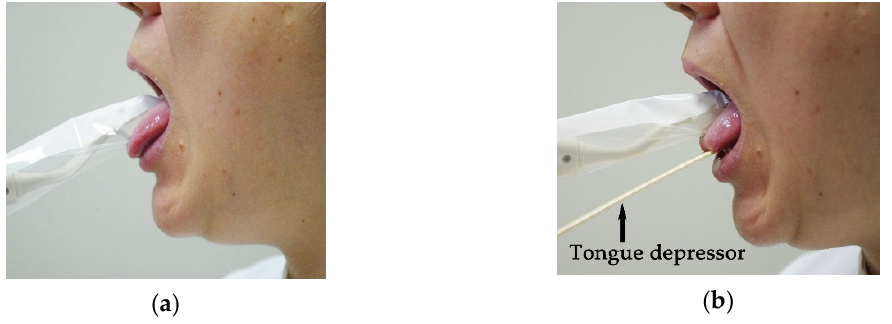
Figure 3. Measurement of oral moisture at lingual mucosa. ( a ) Without tongue depressor. Participants were asked to stick out their tongue. ( b ) With tongue depressor. Tongue depressor was positioned under tongue.